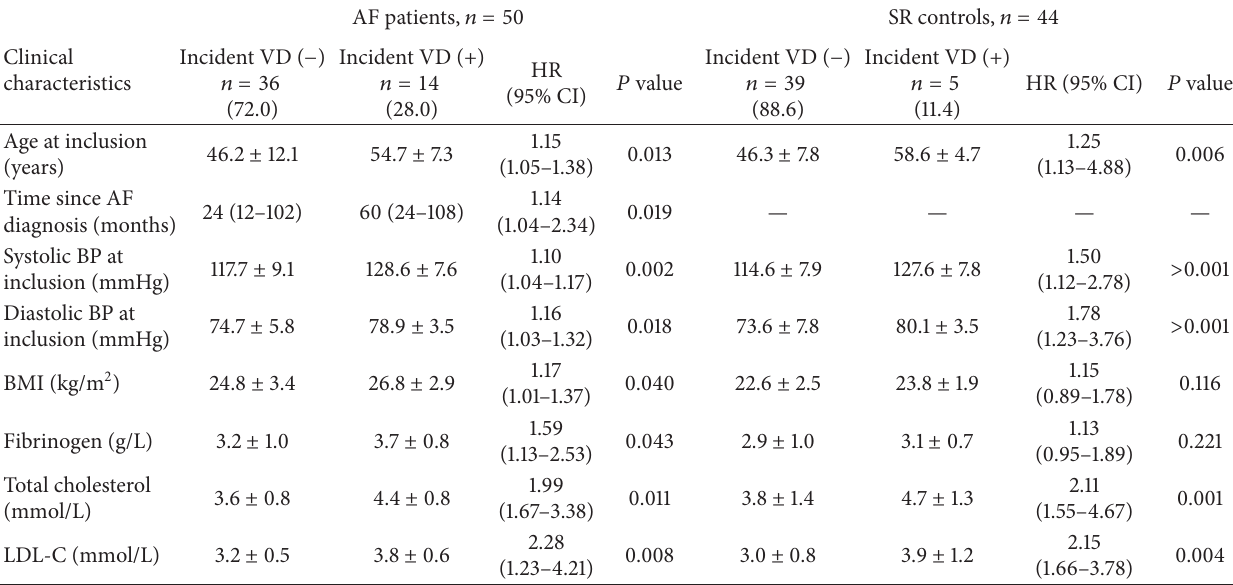
Table 3: Clinical and laboratory variables associated with vascular disease occurrence.